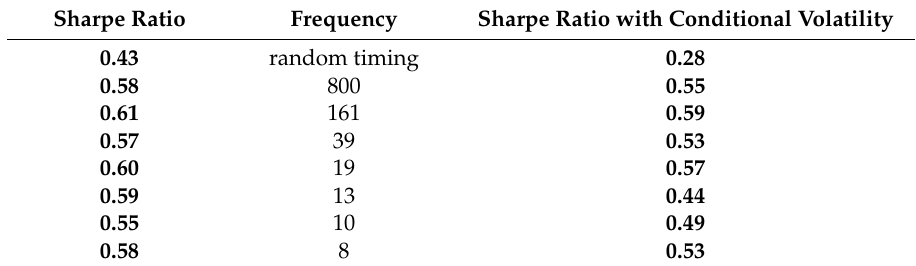
Table 8. Rolling window of 800 trading days, Sharpe ratios, data frequencies, and Sharpe ratios with conditional volatilities (bold denotes significance).